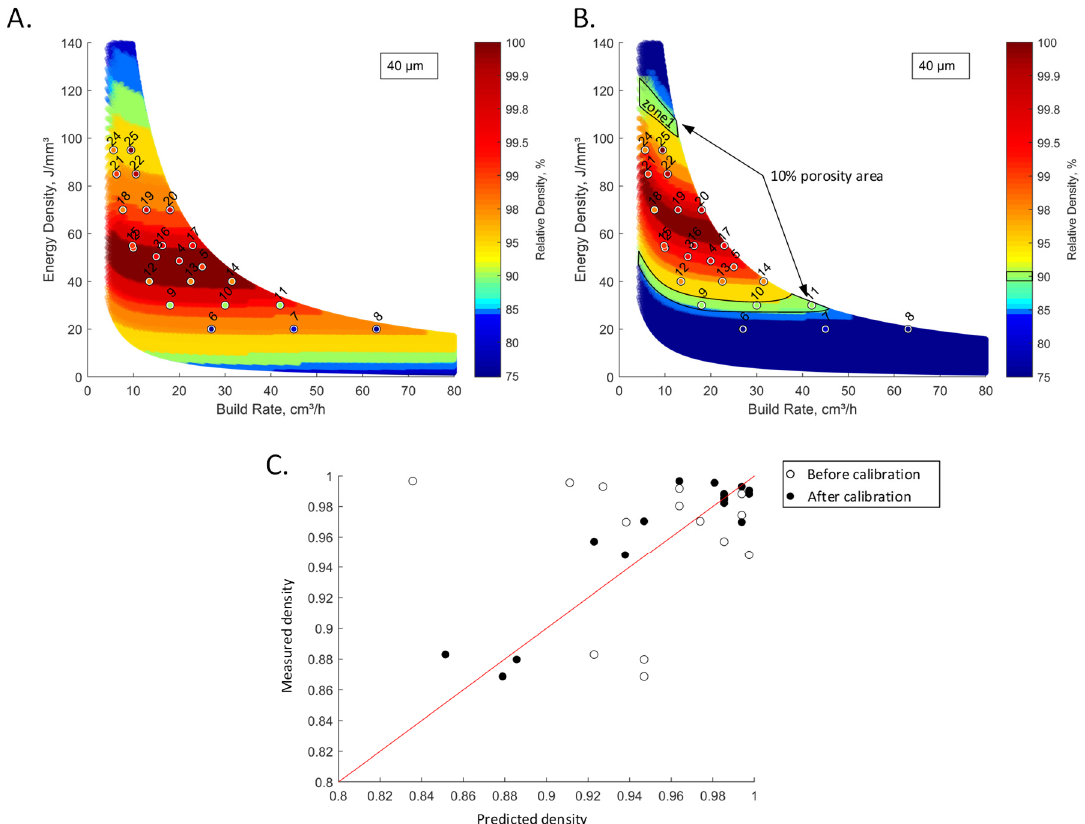
Figure 1. Density processing maps: ( A ) initial processing map and ( B ) adjusted processing map; positions of 25 calibration specimens are indicated on both maps; two zones corresponding to a target relative density of ~90% are indicated on the adjusted processing map; ( C ) discrepancy between the predicted and measured densities before (white dots) and after (black dots) the calibration process.